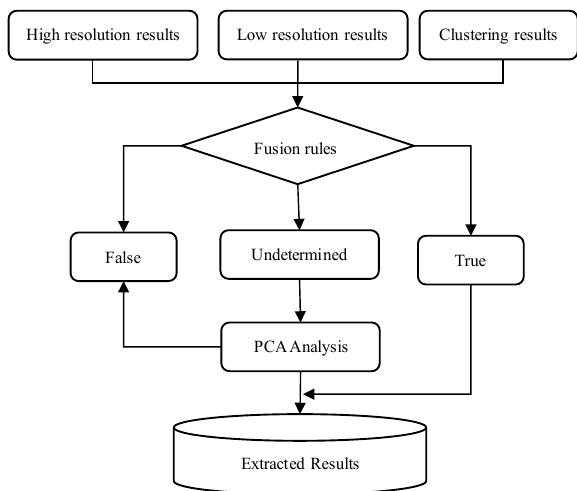
Figure 9. Frame of the road intersections fusion frame.